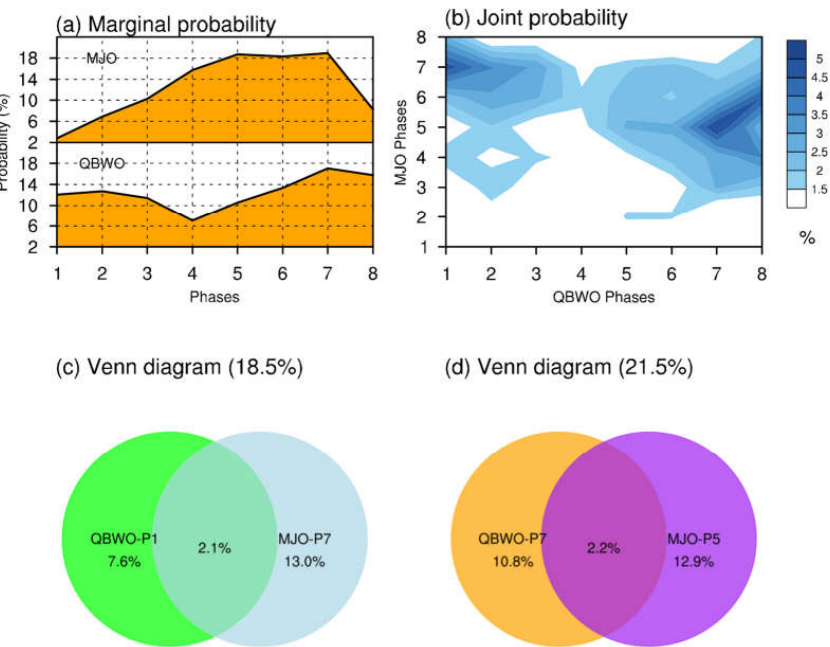
Figure 13. ( a ) The marginal probability distribution (represented as a percentage of cold surge days occurring in an individual ISO mode) of cold surge days in (upper) eight MJO phases and (lower) QBWO phases (shade, unit: %). x-axis represents different ISO phases, and y-axis shows the percentage of cold surge days that fall in each ISO phase. ( b ) The joint probability distribution (represented as a percentage of cold surge days occurring in both ISO modes) of the cold surge days in different MJO and QBWO phases (shade, unit: %). ( c , d ) Venn diagrams that represent the percentage (unit: %) of the occurrence of cold surge days in favorable MJO and QBWO phases simultaneously.